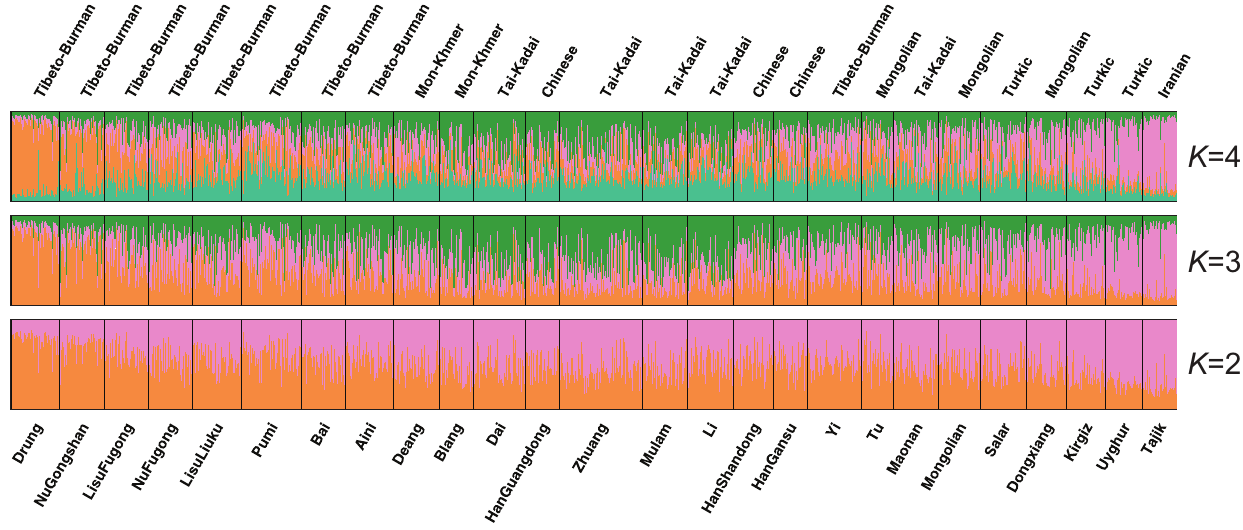
Figure 4. Clustering analysis by structure for the full-loci dataset assuming K =2, 3, 4. Populations were ordered according to their respective unrooted N-J trees. Linguistic affiliations and population names are labelled above and beneath the plot, respectively. Data presented here were the results with highest posterior probabilities during 15 runs of each K setting.